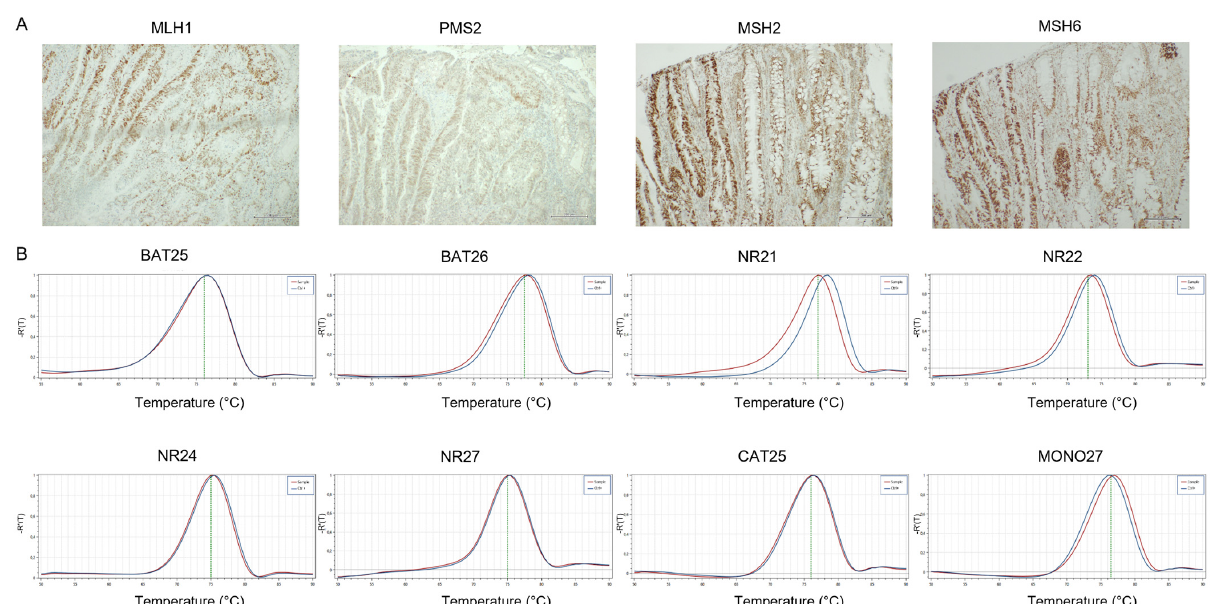
Figure 4. Representative results of CRC case showing paMMR-IHC and MSS by PCR. ( A ) MMR-IHC results: patchy expression of MLH1 and PMS2 in tumor cells with positive internal control (original magnification 10 × ); intact expression of MSH2 and MSH6 in tumor cells (original magnification 10 × ). ( B ) MSS-PCR results: stability of BAT25, BAT26, NR21, NR22, NR24, NR27, CAT25 and MONO27 (red lines indicate samples while blue lines indicate MSS controls).